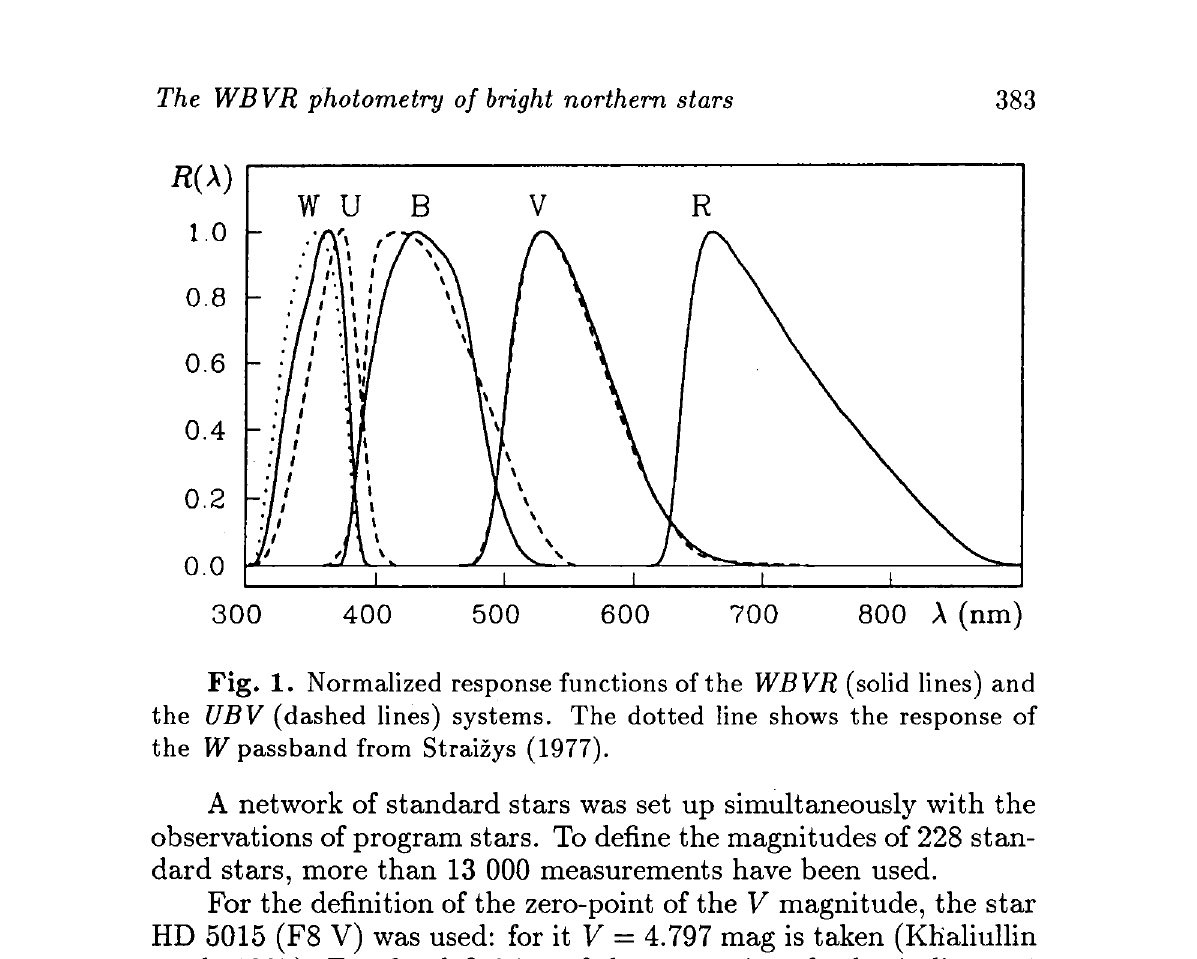
Fig. 1. Normalized response functions of the WBVR (solid lines) and the UBV (dashed lines) systems. The dotted line shows the response of the W passband from Straizys